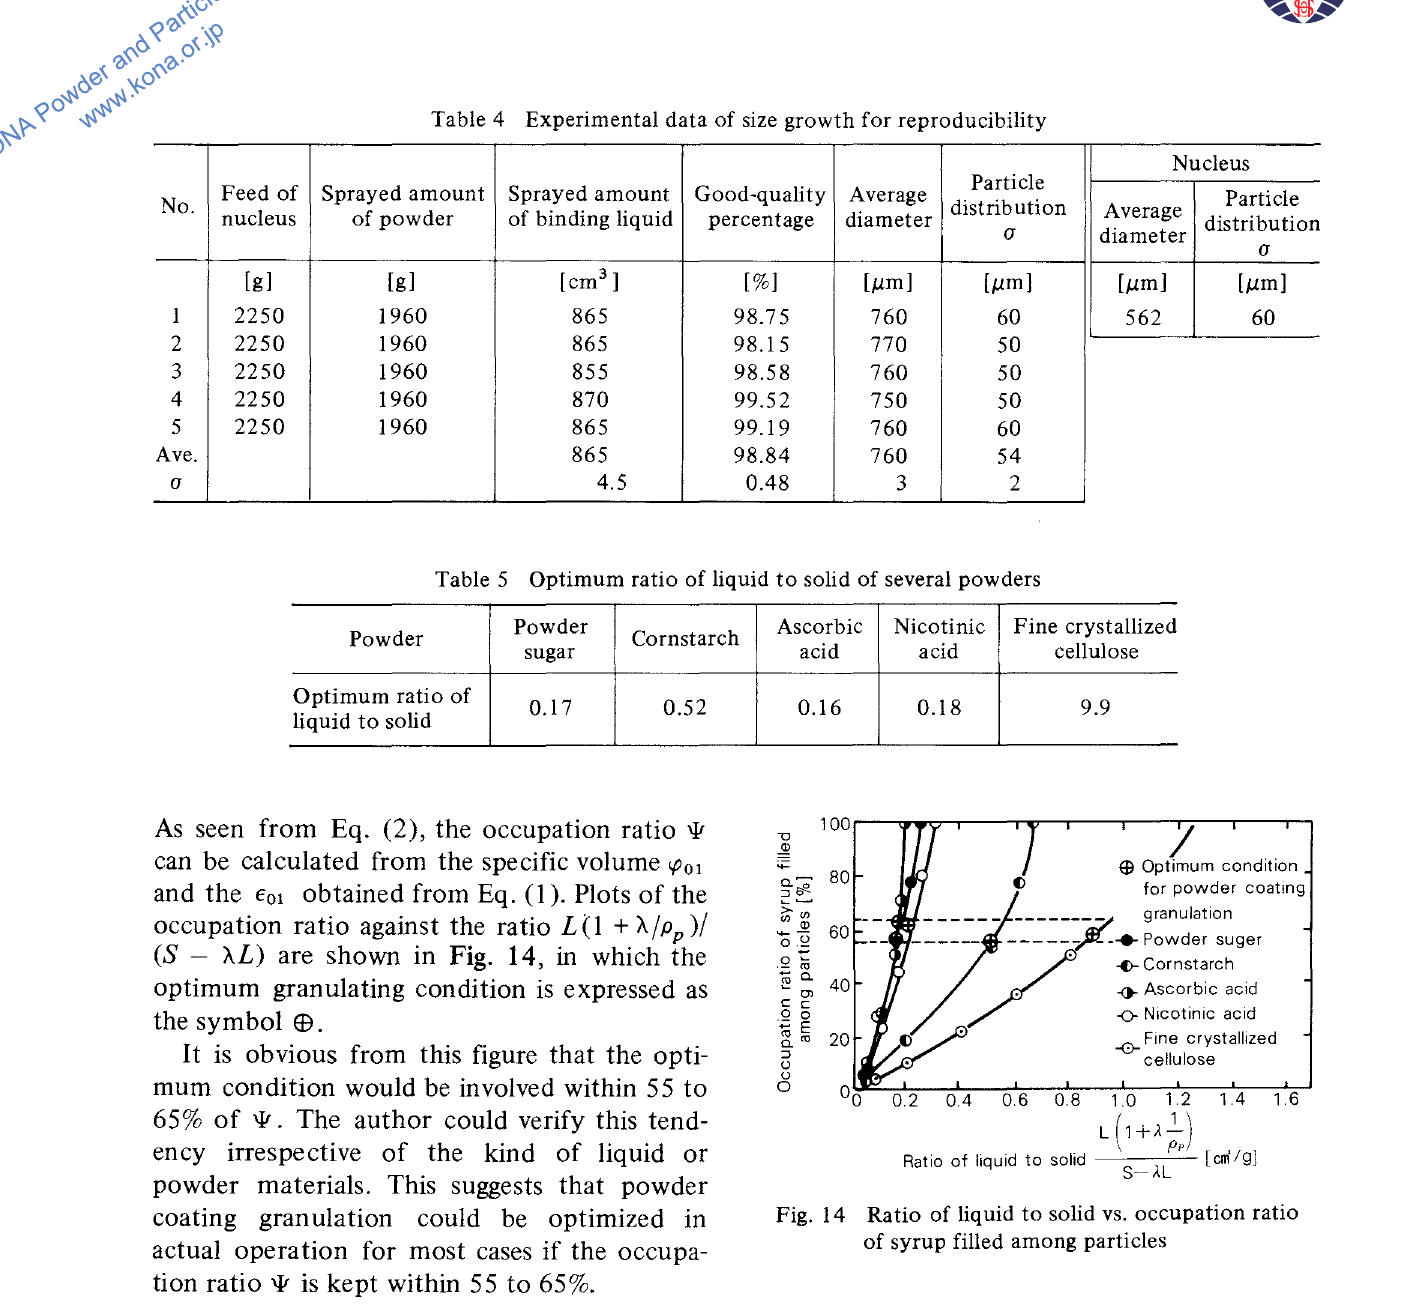
Table 4 Experimental data of size growth for reproducibility